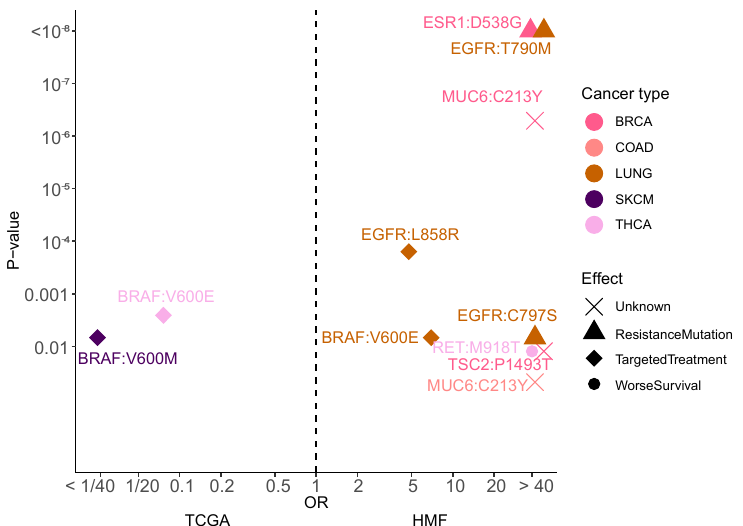
Figure 5. Enrichment of specific variants. A volcano plot showing the variants that are enriched in primary or metastatic cancer. Enrichment determined by Fisher’s exact test. The shape of the dot represents the effect of the mutations based on literature.